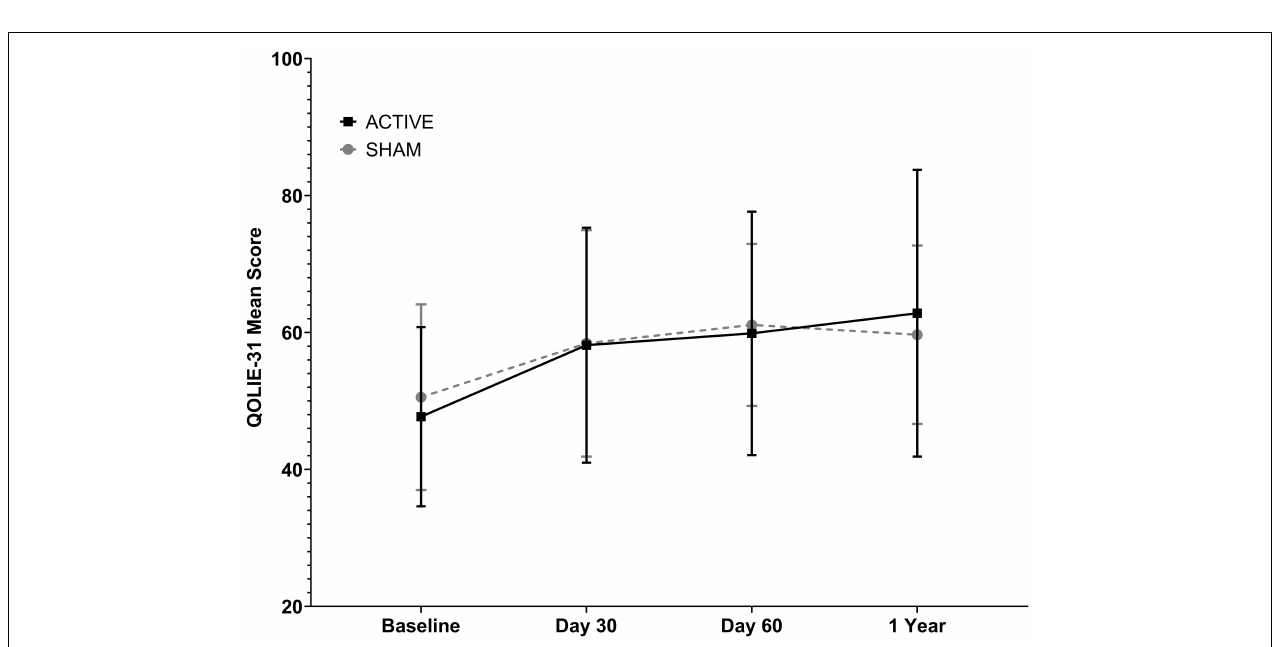
FIGURE 3 | Quality of life assessment in the Sham and Active groups using the Epilepsy Quality of Life Inventory (QOLIE-31) in three stages: (i) pre-treatment; (ii) after 20 daily sessions; (iii) after 1 month performing tDCS once a week for 3 weeks. Data are reported as mean + SD QOLIE-31 score. Data analysis was performed using the Generalized Estimation Equations (GEE) model. There was no statistically significant difference between groups considering the type of treatment.